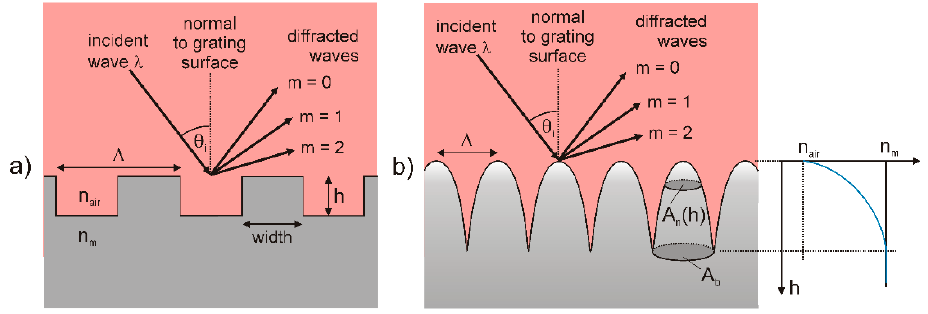
Figure 9. Schematic illustration of a plane wave incident on a periodic surface grating with ( a ) rectangular groove profile and ( b ) gradient profile.